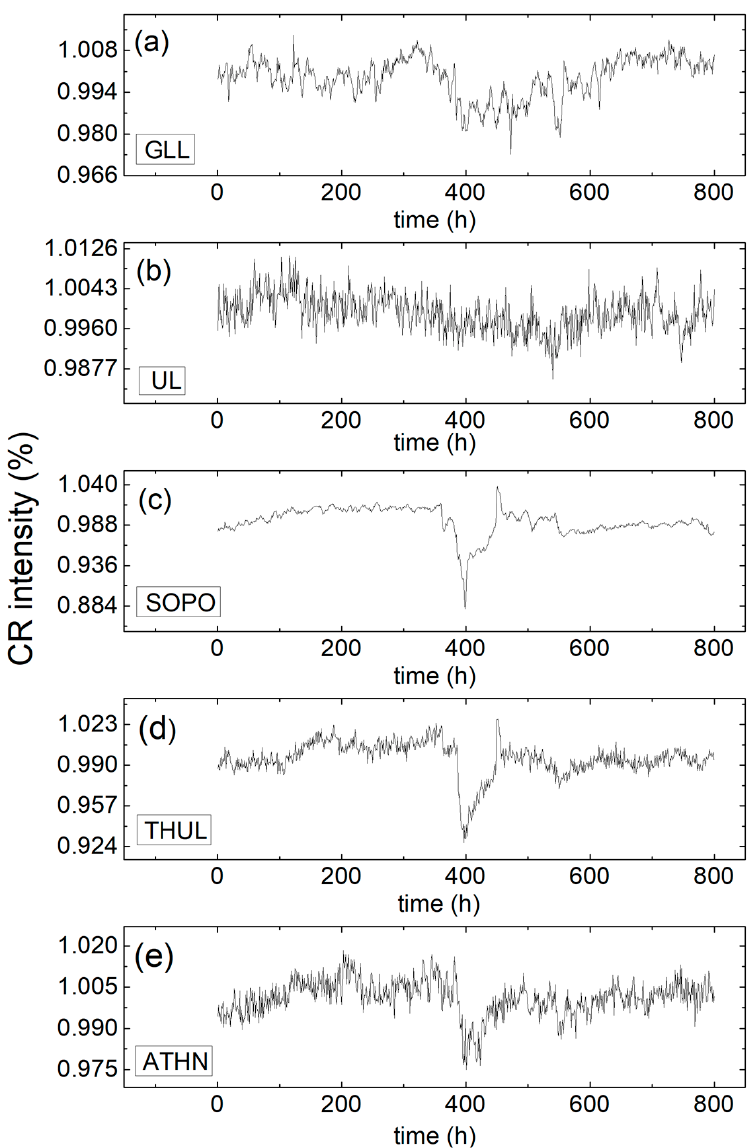
Figure 7. Normalized time series of secondary CR flux detected at several ground and one shallow-underground monitors: ( a ) ground (GLL) and ( b ) underground (UL) detector at Belgrade muon station, ( c ) South pole NM (SOPO), ( d ) Thule NM (THUL), and ( e ) Athens NM (ATHN).